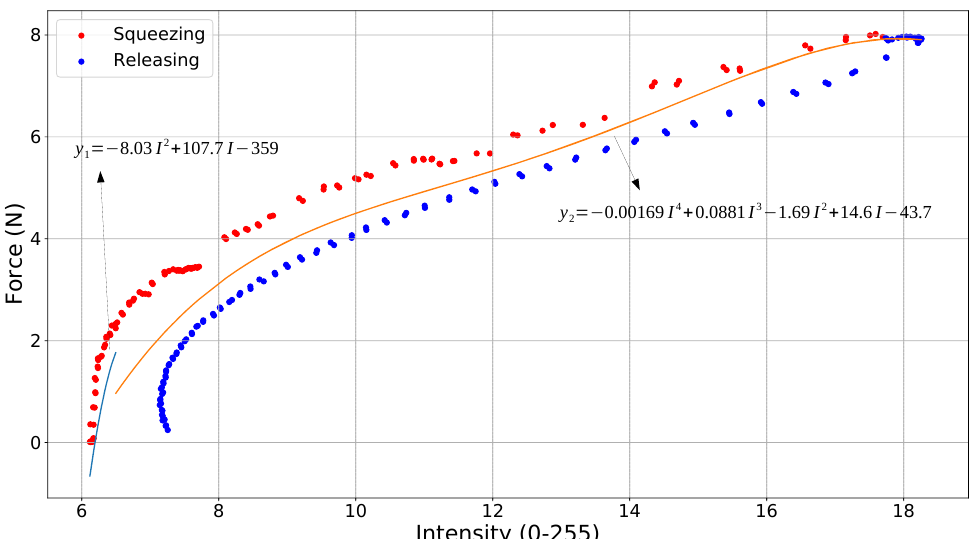
Figure 5. Light intensity variation due to the applied force on photoelastic silicone rubber in the proposed sensor